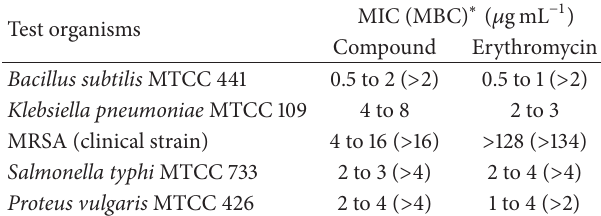
Table 5: Antimicrobial potential of antibiotic, J18-04, against diff- erent